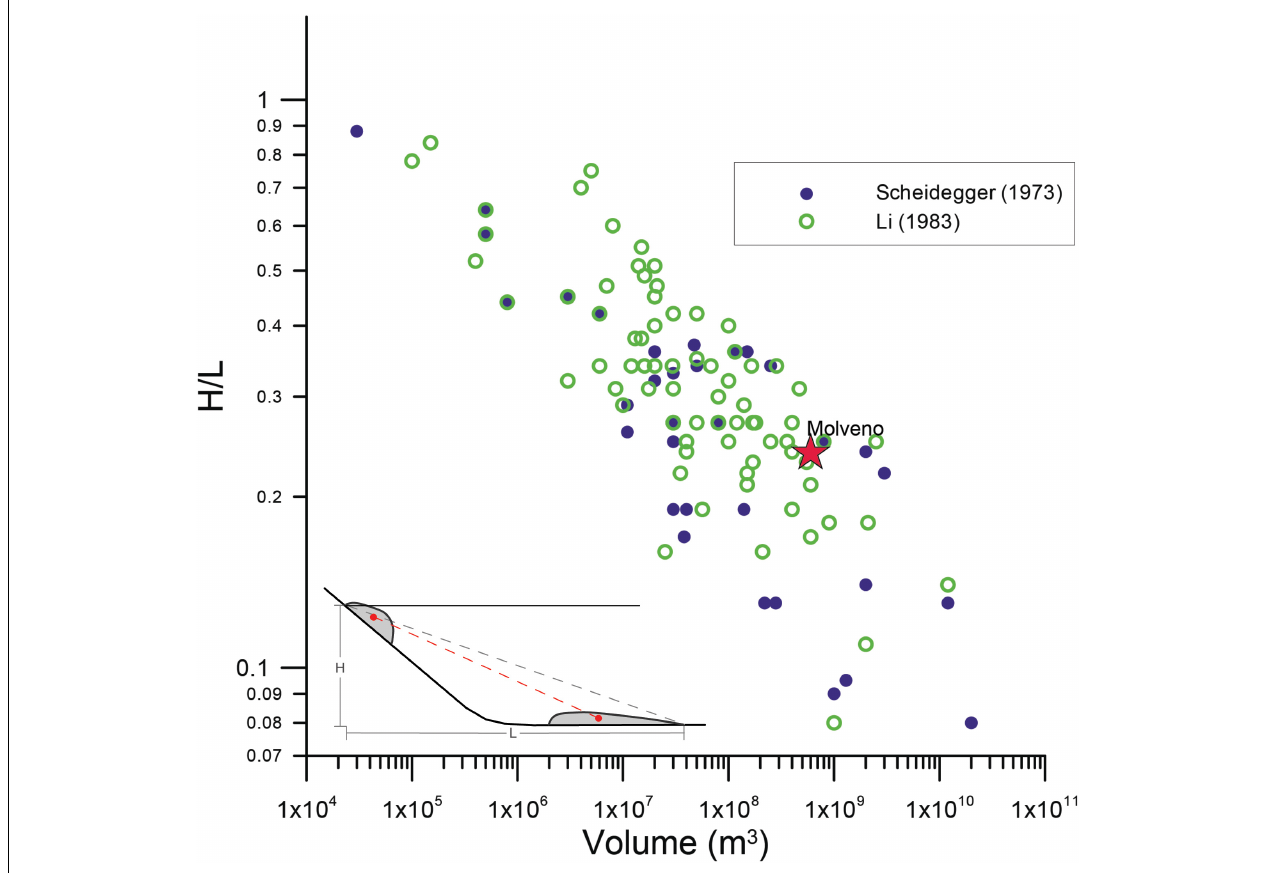
FIGURE 7 | Scheidegger-Plot (Volume vs. H/L; Scheidegger, 1973) extended by a dataset of Li (1983). The rock avalanche of Molveno is marked with a red star. The inset shows the definition of the fall height (H) and runout length (L).